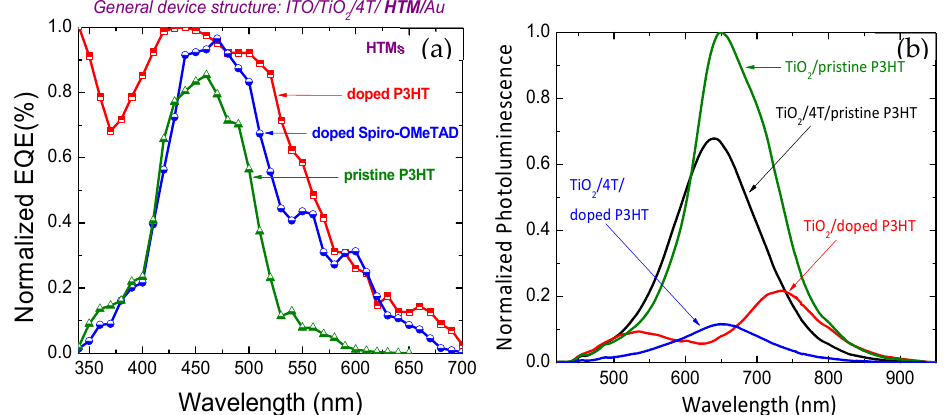
Figure 7. ( a ) Carrier generation and light harvesting properties of ITO/TiO 2 /4T/P3HT or doped P3HT/Au solar cells. ( b ) Photoluminescence quenching of TiO 2 /4T/P3HT and TiO 2 /4T/doped P3HT films attributed due to enriched exciton dissociation via reduced carrier recombination at the TiO 2 /polymer interface.